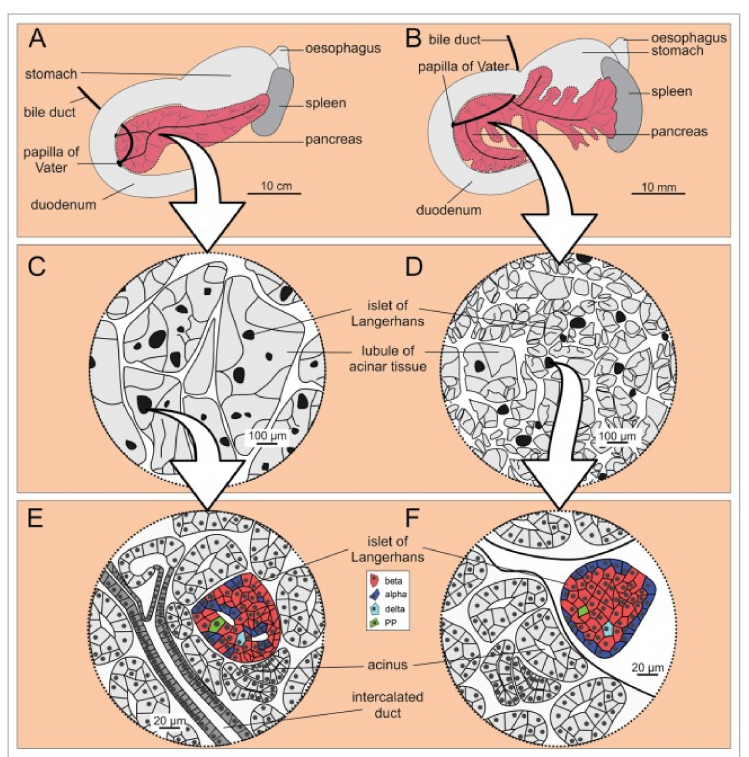
Figure 1. Microscopic anatomy of human ( A , C , E ) and mouse ( B , D , F ) pancreas. ( A , B ) Macroscopic anatomy of human and mouse pancreas, respectively. ( C , D ) Enlargement of a portion of the pancreas shows that the lobules are larger in humans than in mice, whereas the islets of Langerhans are of comparable size in humans and mice. ( E , F ) The cell composition and location of the islets of Langerhans within the pancreas are markedly different in the two species. Note the more diffusely distributed endocrine cells in humans ( E ) and the mantle-core pattern in mice ( F ) [29]. Reprinted (adapted) from Creative Commons Attribution License CC BY